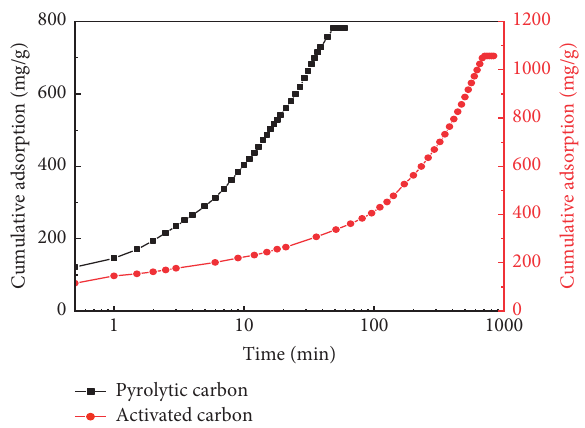
Figure 8: Comparison of cumulative adsorption of pyrolytic carbon and activated carbon on crude